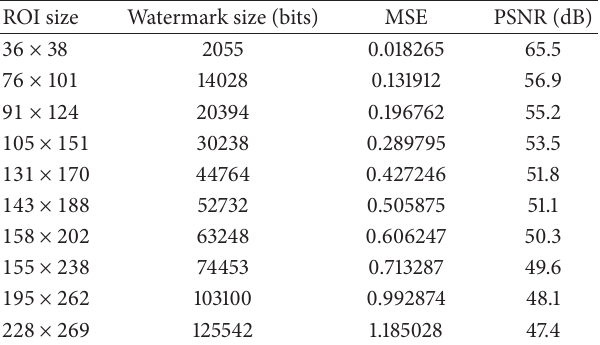
Table 3: Embedding performance of MR scan image of size 512 × 512 .